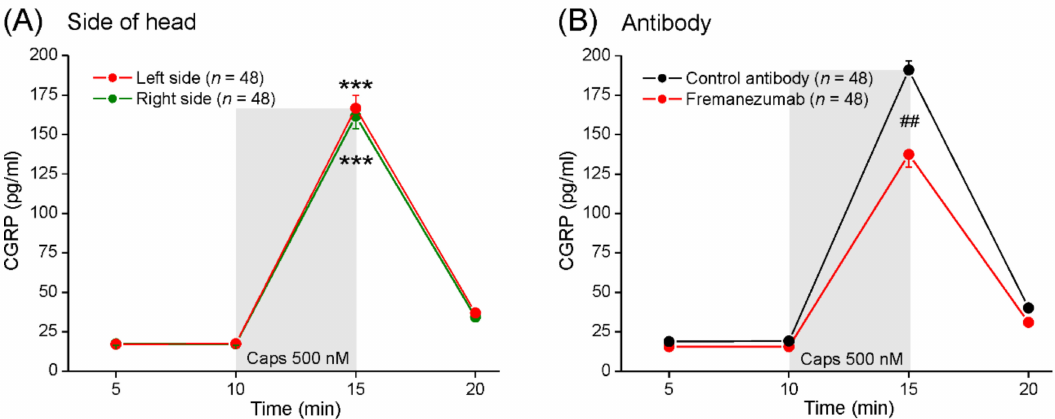
Figure 1. Sequential CGRP release from the dura mater 10 days after injection of antibodies. Data were grouped according to the head side of animals ( A ) and control antibody or fremanezumab treatment, respectively ( B ). Basal release was measured 5 and 10 min after application of physiological solution (SIF) and stimulated release after capsaicin application (Caps 500 nM). Repeated measures ANOVA with Tukey post hoc test, ***: p < 0.0001 to basal value ( A ) and ##: p < 0.001 between antibodies ( B